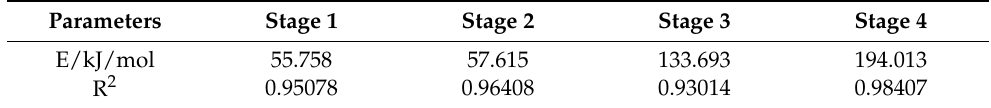
Table 15. Reaction kinetic parameters of Kerjian coal.